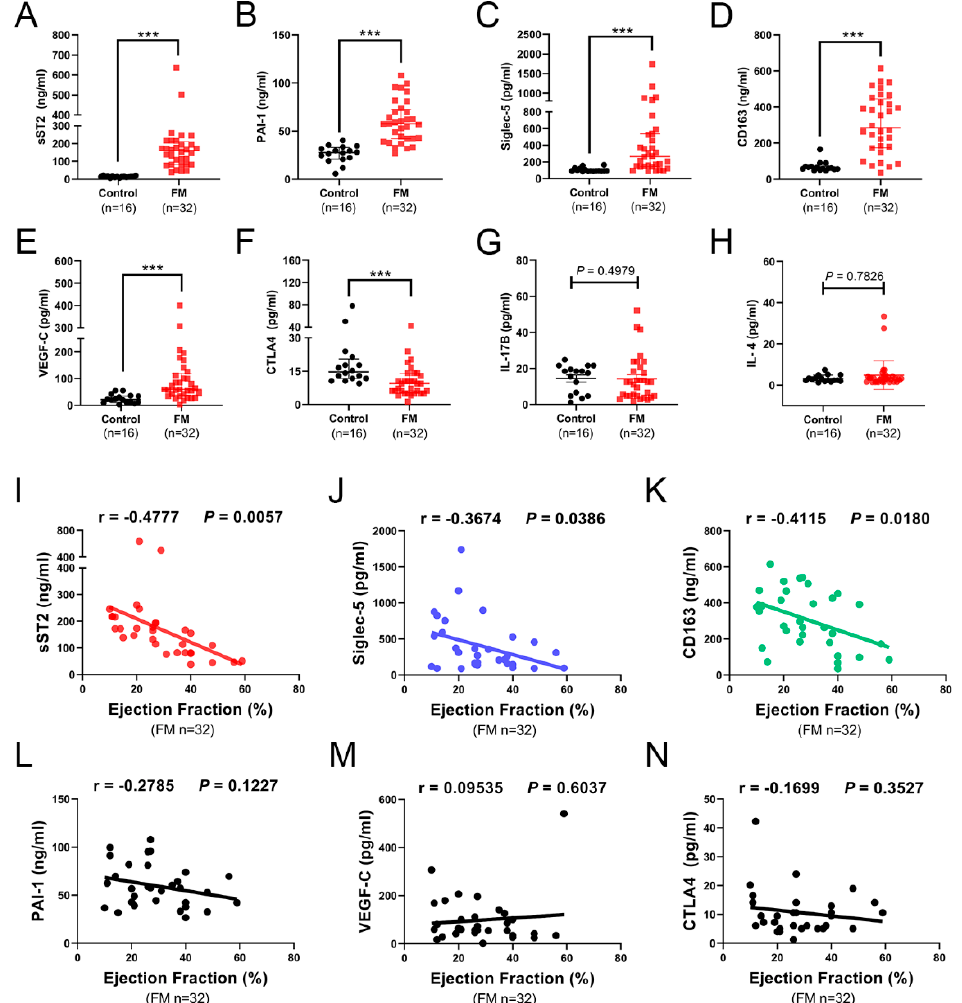
Figure 2. Plasma levels and correlation analysis of eight cytokines screened using human cytokine arrays analysis in patients with FM. Circulating concentrations of sST2 ( A ), PAI-1 ( B ), Siglec-5 ( C ), CD163 ( D ), VEGF-C ( E ), CTLA-4 ( F ), IL-17B ( G ), and IL-4 ( H ) in FM patients (n = 32) and control individuals (n = 16) were measured using ELISA. Data are presented as medians and quartile 1 to quartile 3 [Q1–Q3], and a Mann–Whitney test was used to elevate the differences; *** p < 0.001. Correlation analysis of plasma sST2 ( I ), Siglec-5 ( J ), CD163 ( K ), PAI-1 ( L ), VEGF-C ( M ), and CTLA-4 ( N ) with ejection fraction values in 32 patients with FM. r indicates the correlation